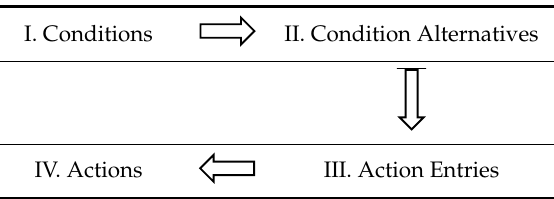
Table 1. The four quadrants of a decision table.